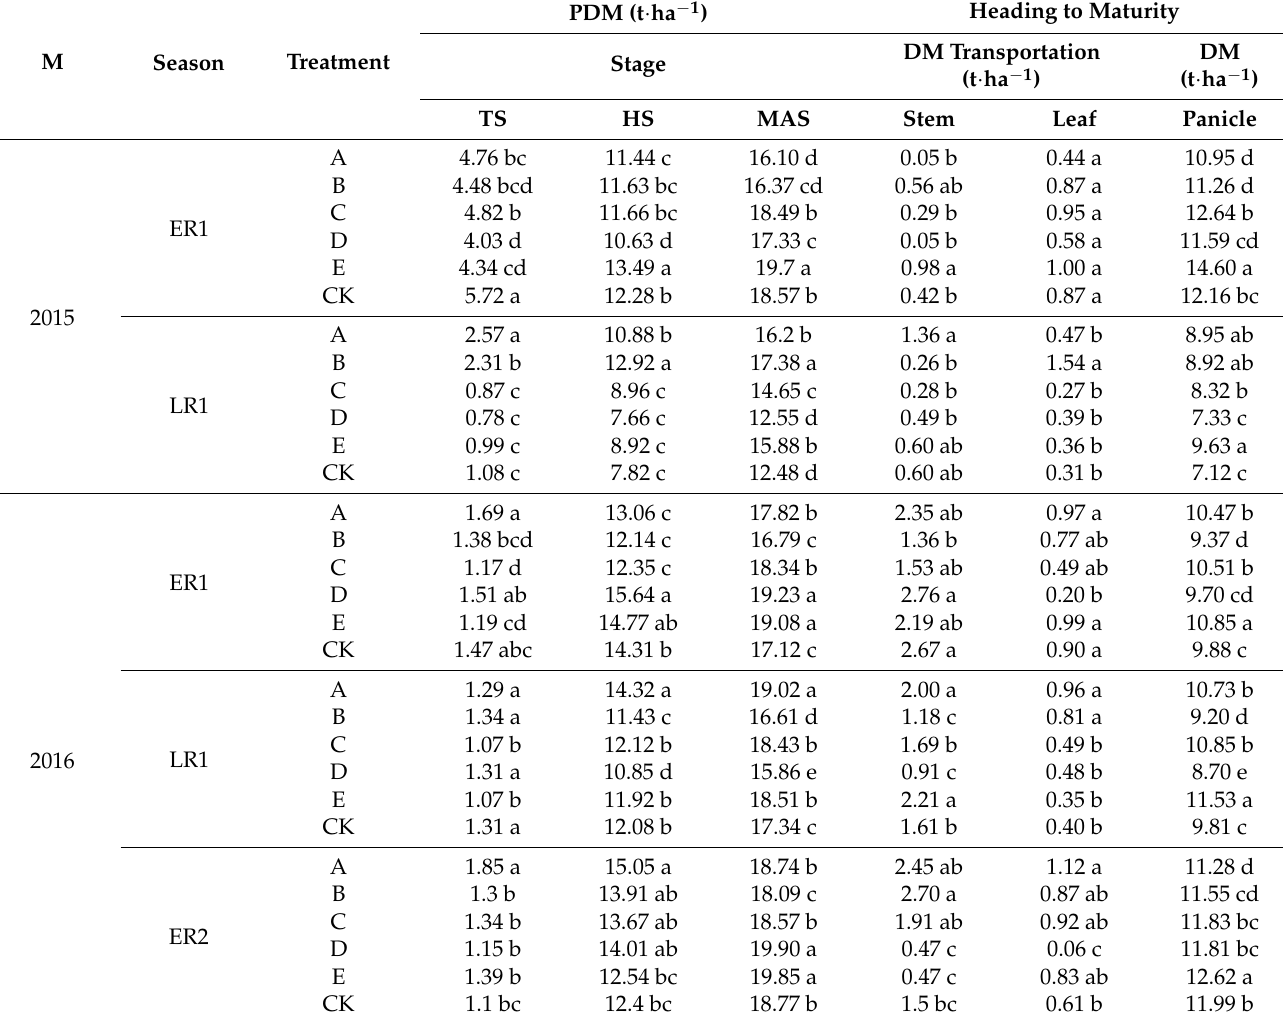
Table 6. Effect of different treatments on grain yield and yield components in 2015 and